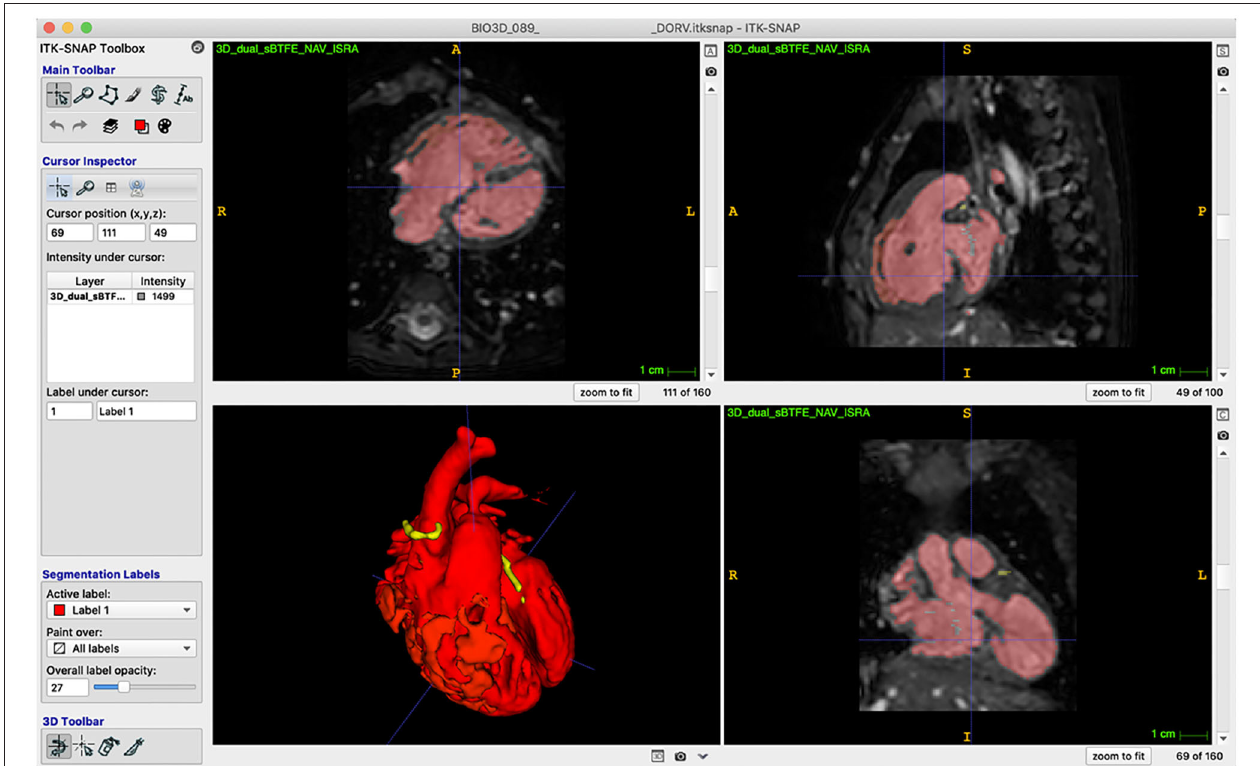
FIGURE 1 | ITK Snap Segmentation. ITK toolbox on the left side of the screen. Axial (up left), sagittal (up right), 3D reconstruction (down left), and coronal (down right) views in ITK-Snap. Thresholding and manual segmentation were applied to select blood pool (red) and coronary arteries